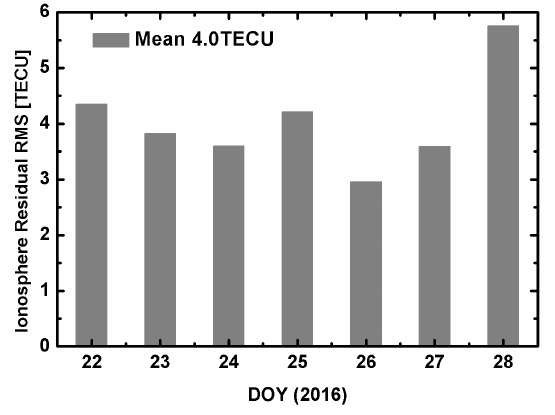
Figure 8. The average accuracy of real-time ionospheric model.